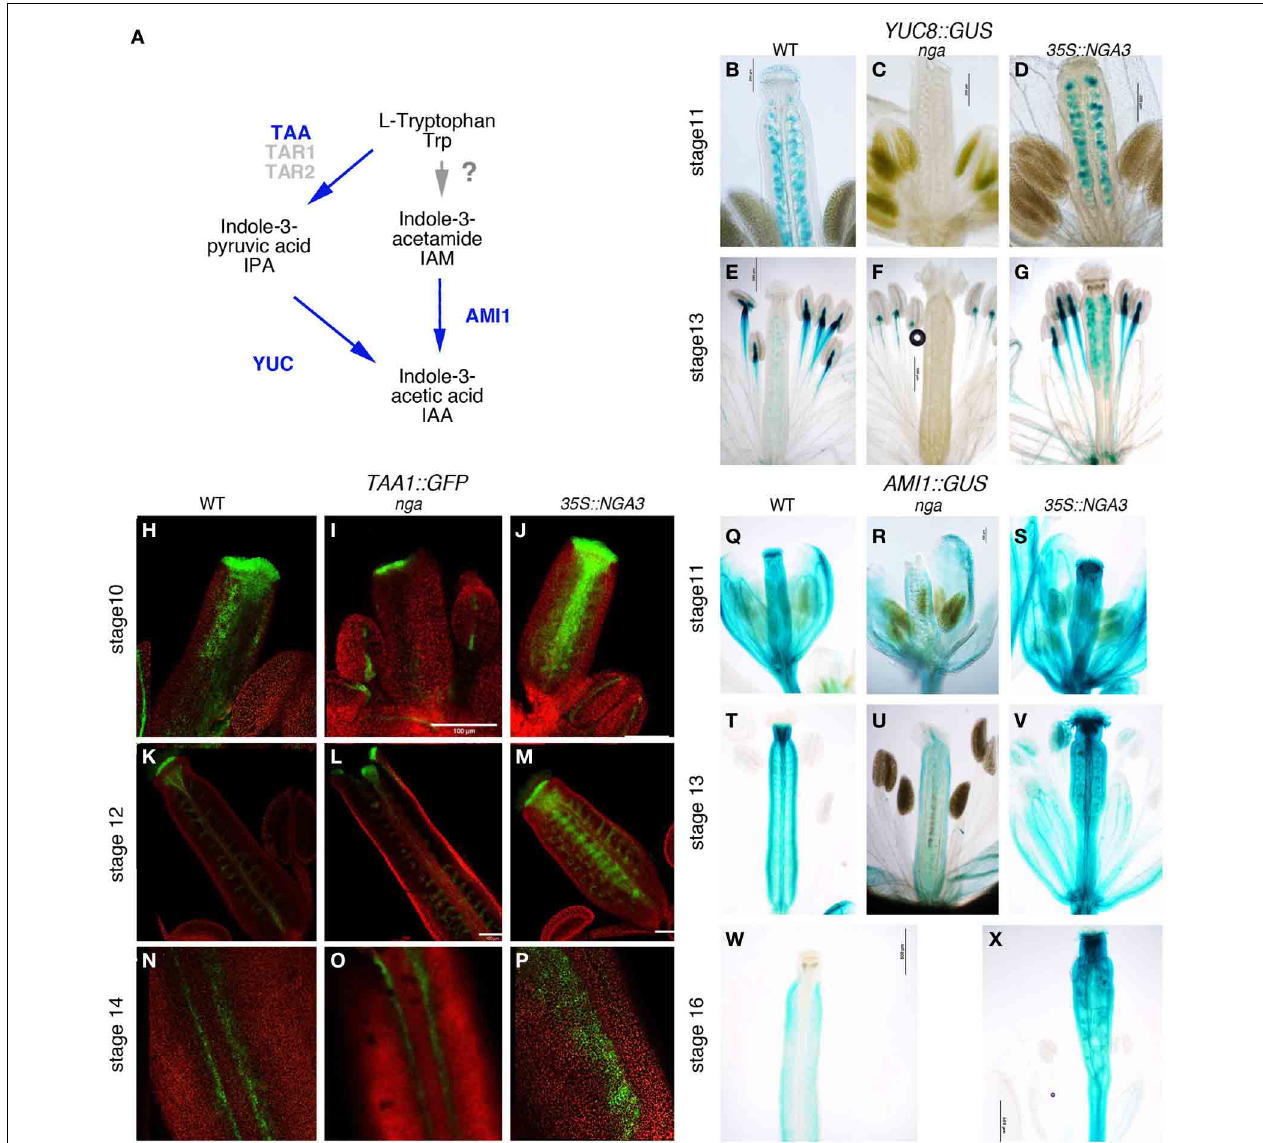
FIGURE 2 | Effect of NGA altered activity on the expression of genes involved in local auxin synthesis. (A) Simplified scheme of the presumptive pathways for IAA biosynthesis studied in this work, adapted from Mano and Nemoto (2012). Genetic functions analyzed in this work are noted in blue. Question mark on the TRP > IAA pathway denotes that the conversion of TRP to IAM has not been demonstrated in plants (B–G) Histochemical detection of GUS activity driven by the YUC8 promoter in wildtype (B,E) , nga quadruple mutants (C,F) and 35S::NGA3 gynoecia